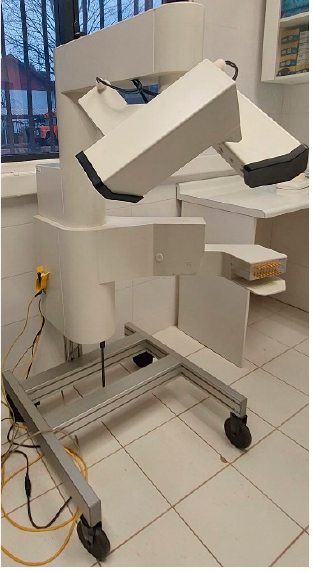
Figure 1. AG501 EMA. Nine sensors were used: three reference, three active sensors to take measurements, and three sensors in an accessory of the articulograph called the Bite Plane. The sensors were calibrated before taking the